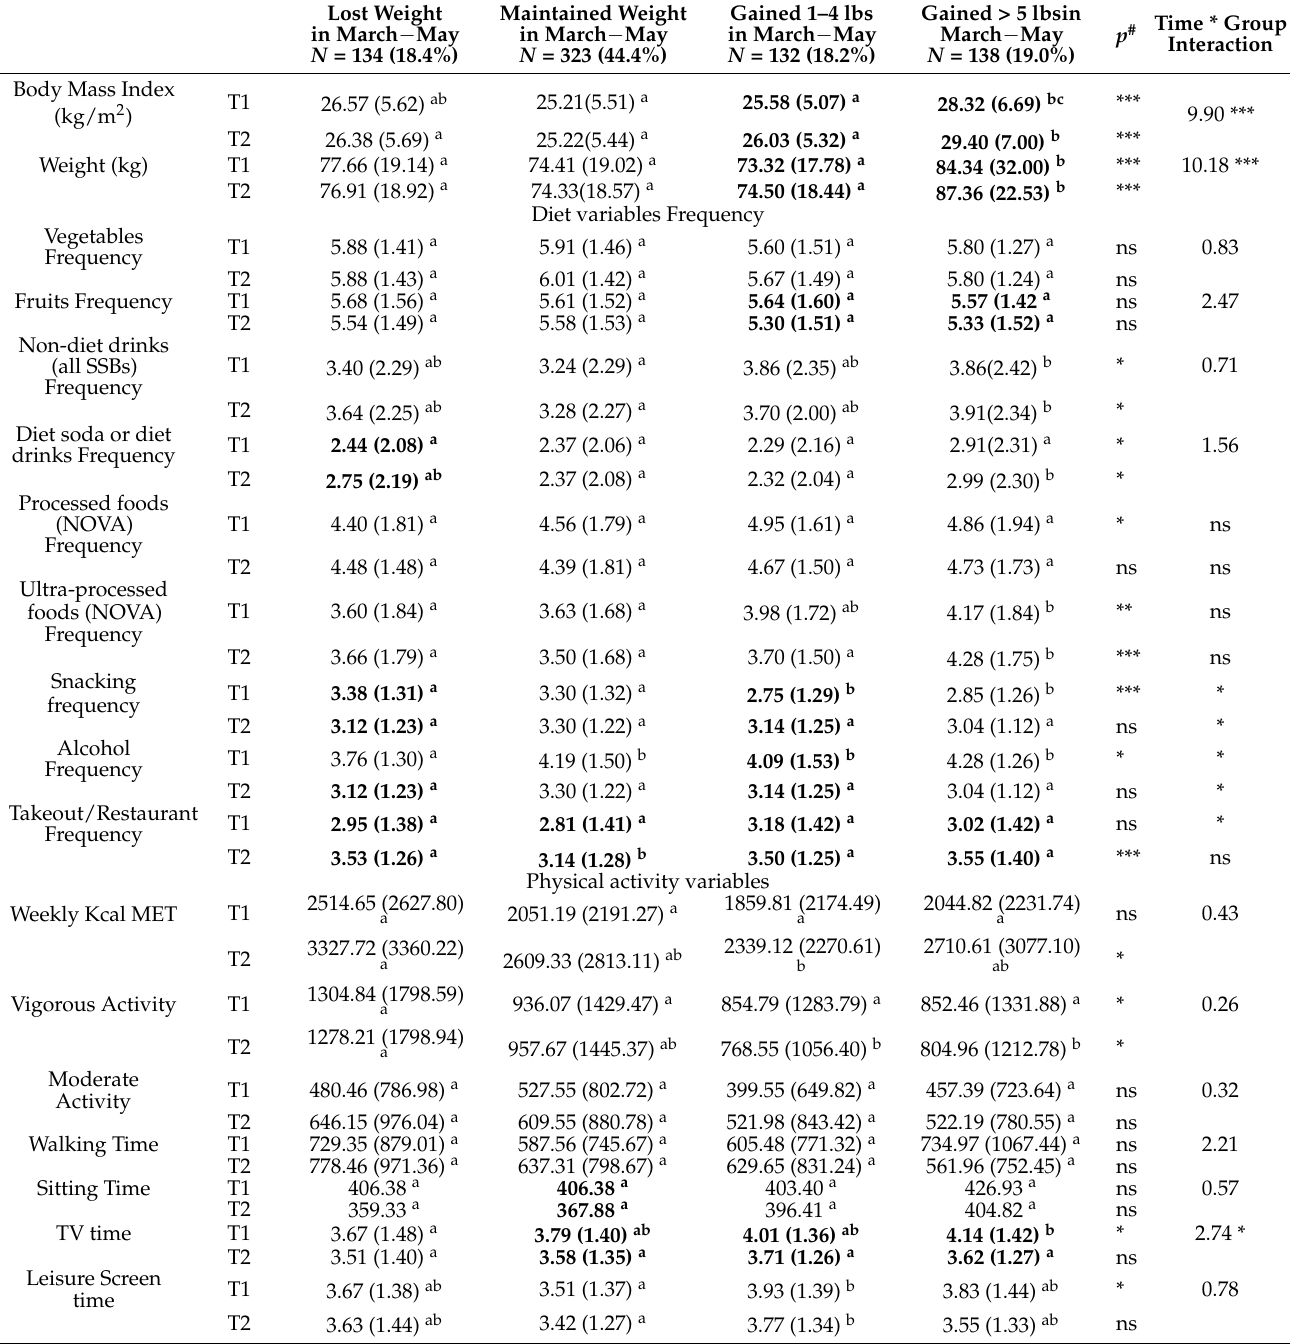
Table 2. Self-reported frequency of diet and physical activity behaviors across weight risk group during the peak lockdown (T1) and post the initial COVID-19 lockdown